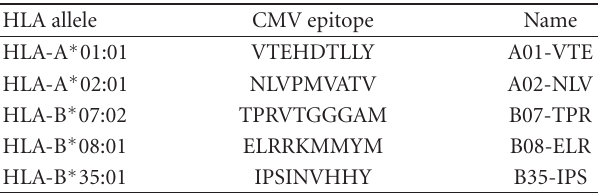
Table 1: Major HLA class I alleles and defined CMV HLA class